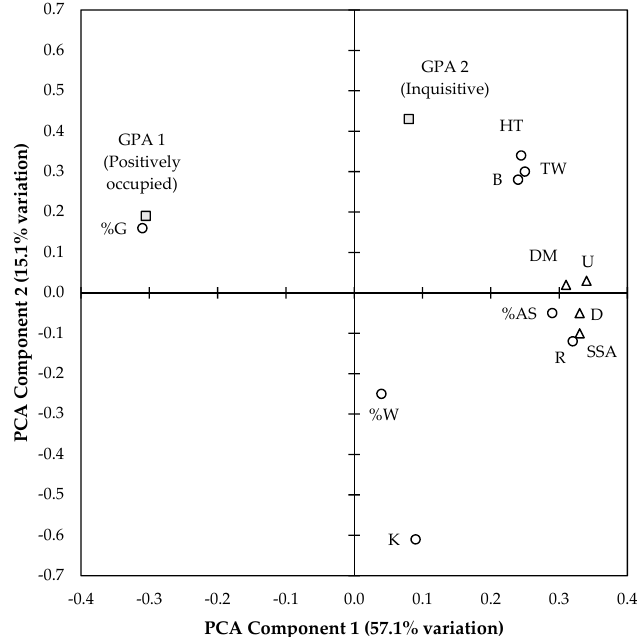
Figure 2. Summary of Principal Component Analysis (PCA) dimensions comparing scores for breech soiling variables, quantitative behaviour scoring, and Qualitative Behavioural Assessment (QBA). Breech soiling variables (triangles): Dag score (D), Dag moisture score (DM), Urine stain score (US), and Size of flystruck area (SSA). Quantitative behaviour scoring (circles): Abnormal standing (AS), Grazing (G), Biting rump region (B), Head turn (HT), Kicking (K), Tail wagging (TW), Restlessness (R), and Walking (W). QBA (squares): Generalised Procrustes Analysis (GPA) scores on dimensions 1 and 2. Animals 2019 , 9 , x